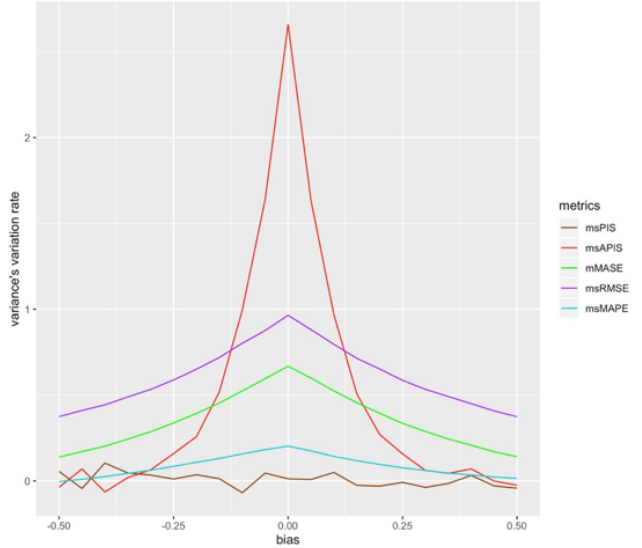
Figure 6. Standard deviation variation rate in function of